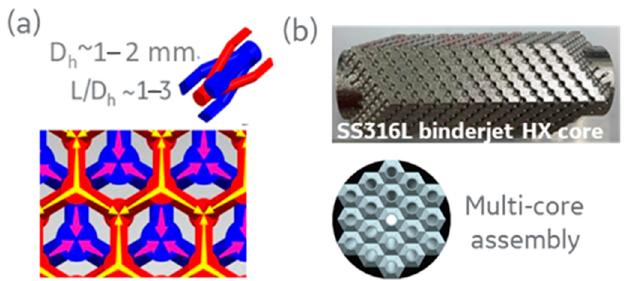
Figure 1. High temperature binder jet HXs—( a ) Trifurcating flow path ( b ) fabricated SS316L HX core and modular assembly options.